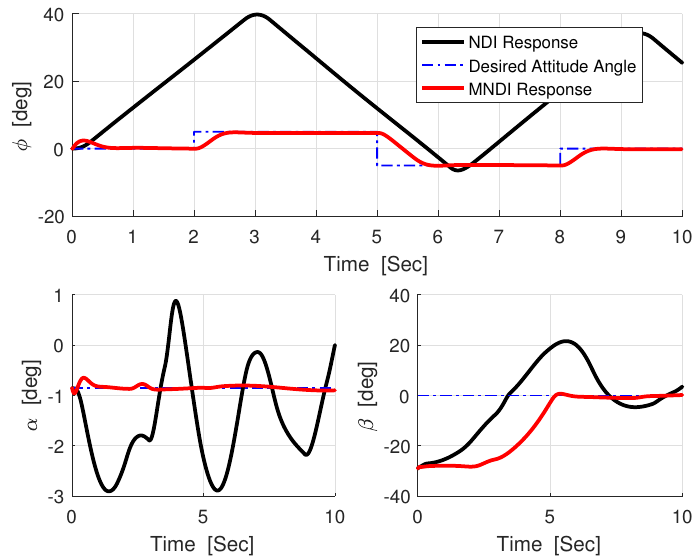
Figure 17. Attitudes response with NLDI and MNLDI with roll angle excitation with wind disturbances and